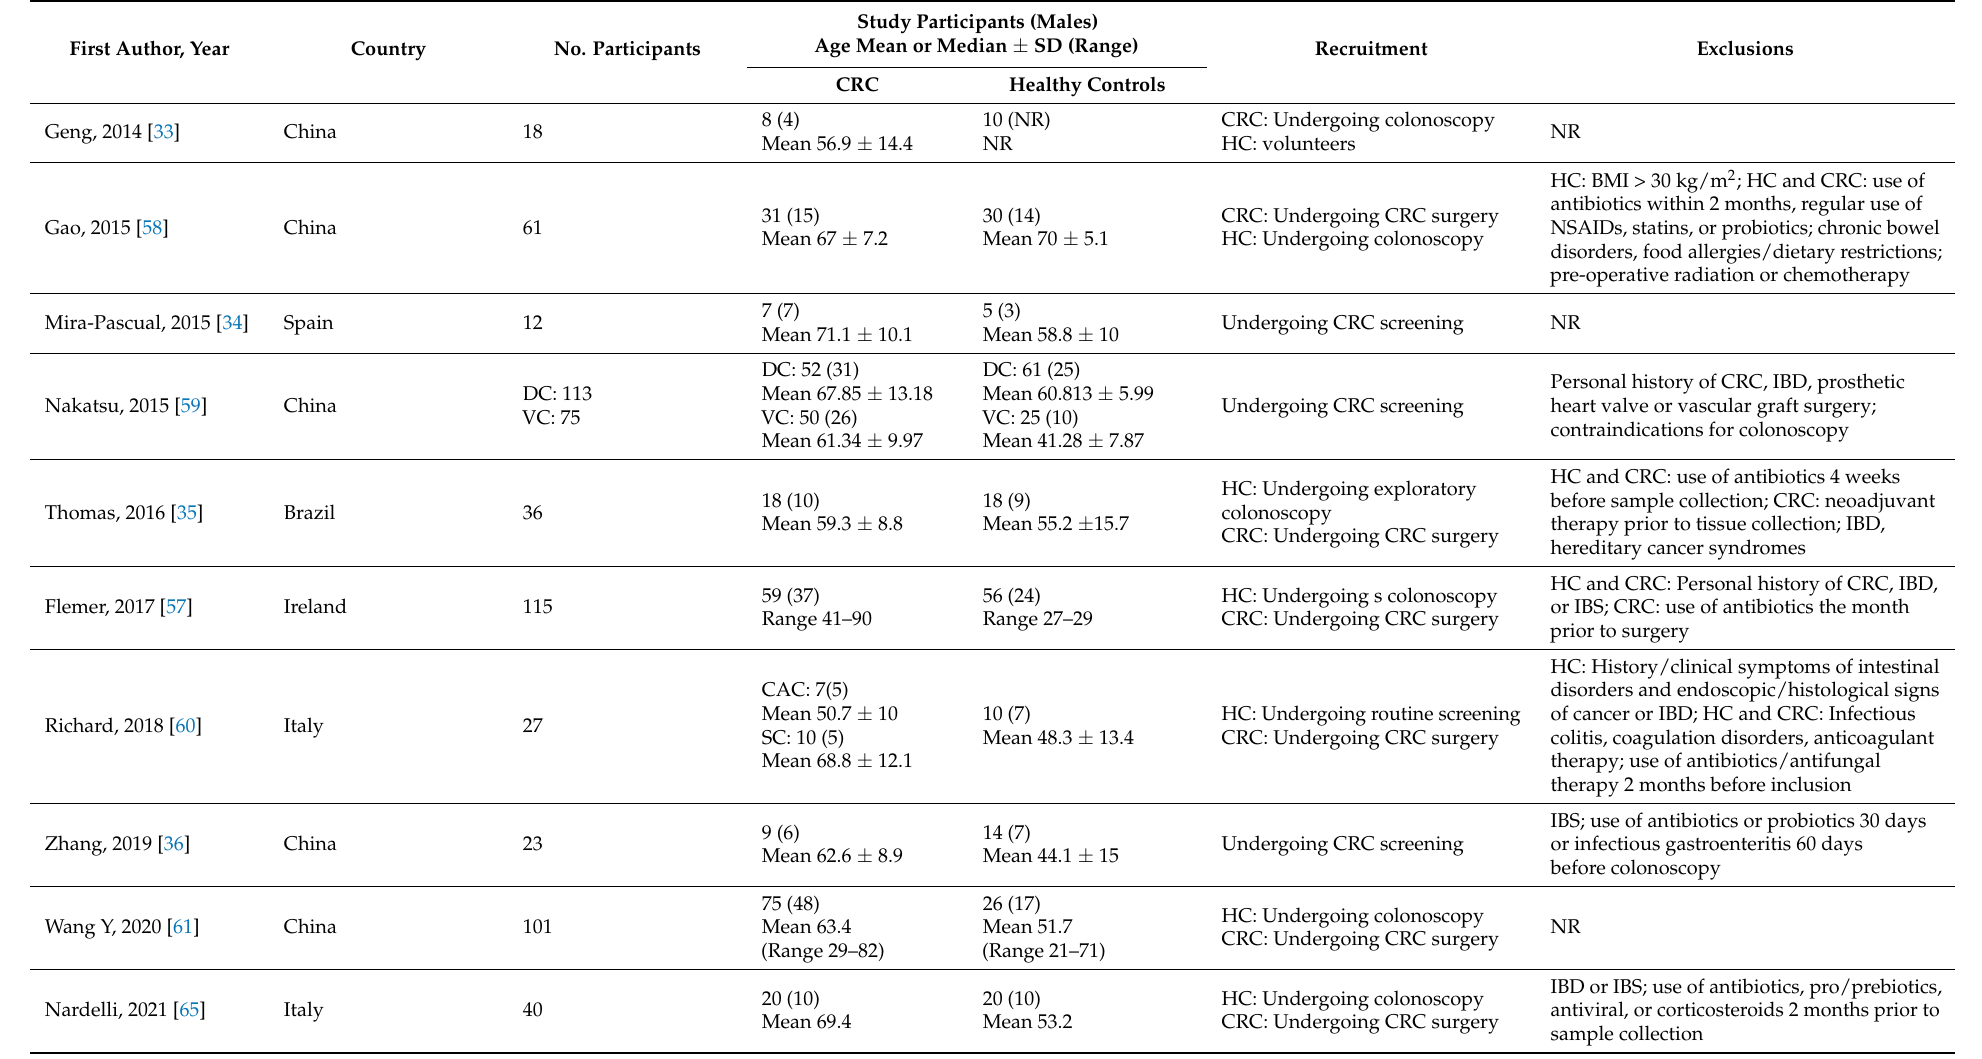
Table 1. Baseline characteristics of studies determining the mucosal colorectal microbiota of CRC patients and healthy